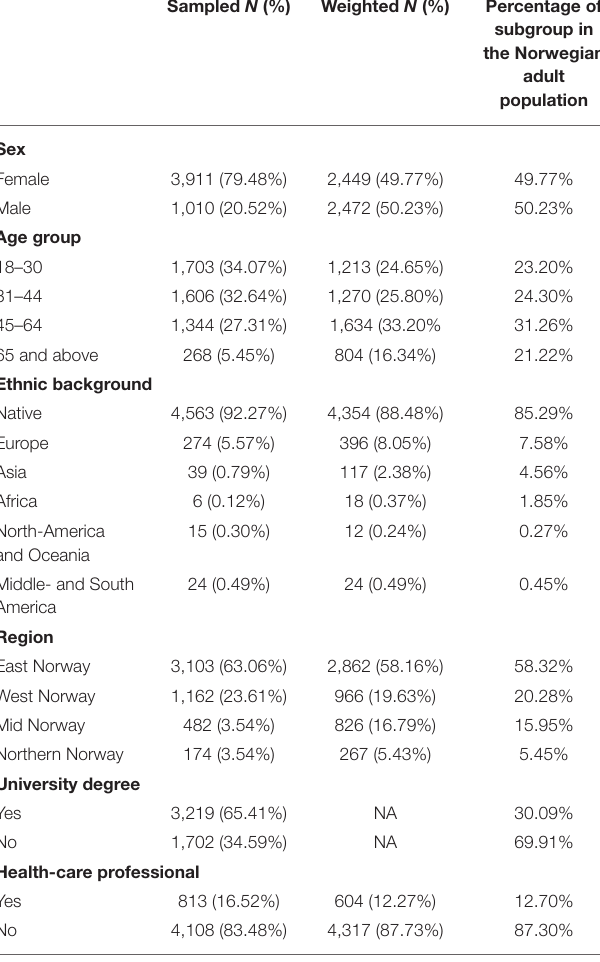
TABLE 1 | A table revealing the proportion of the sampled participants. TABLE 2 | Differences in mean levels of insomnia symptoms, as measured by Bergen Insomnia